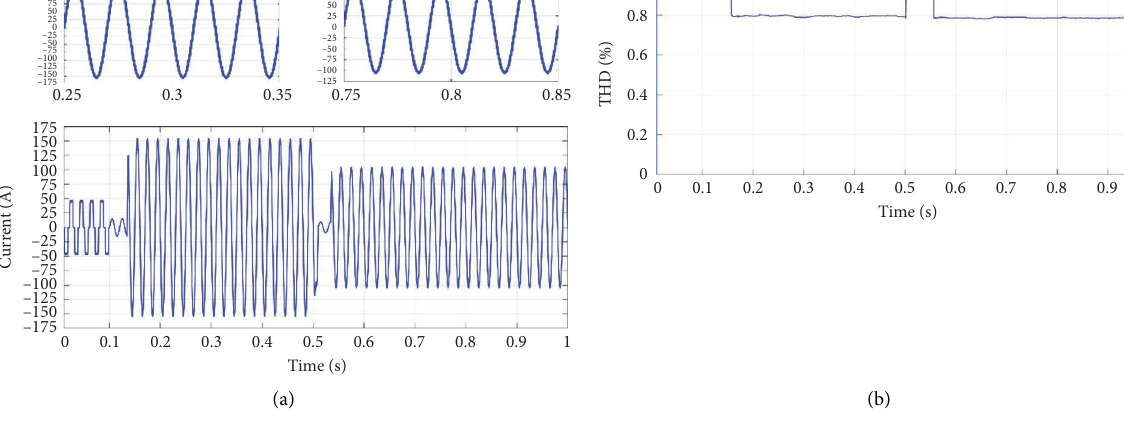
Figure 11: Grid current (a) and its THD (b).